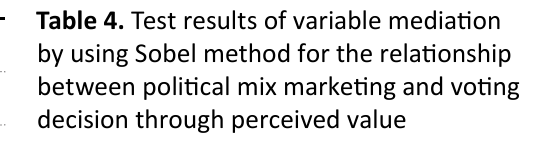
Table 4. Test results of variable